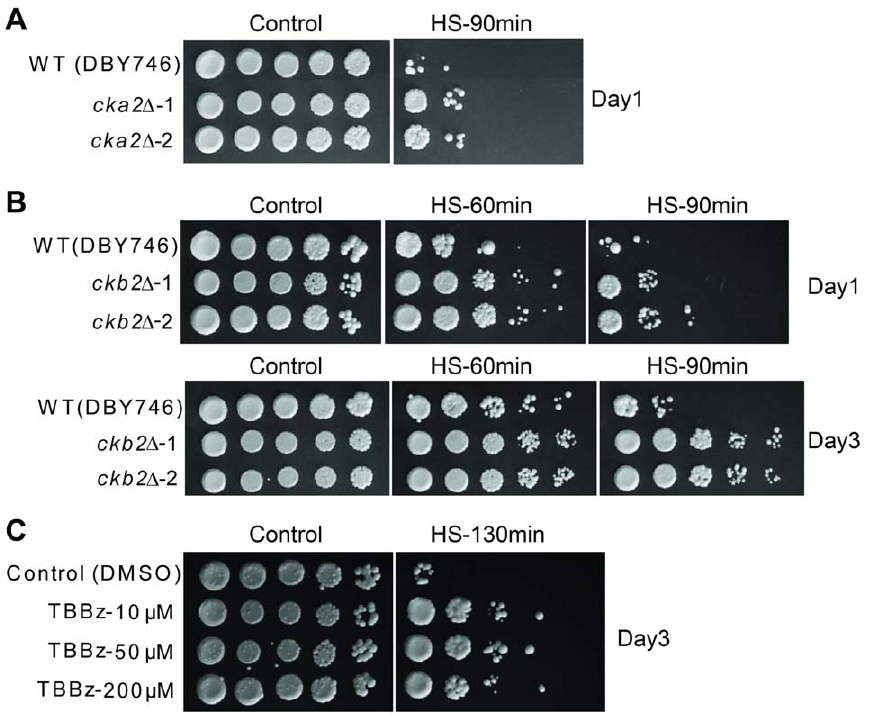
Figure 6. Role of CK2 in the regulation of heat-shock resistance. (A) Heat-shock resistance of two different cka2 D isolates generated in the DBY746 genetic background monitored at day 1. (B) Heat-shock resistance of DBY746 and of two different cultures of the ckb2 D mutant at day 1–3. (C) Heat-shock resistance of DBY746 yeast treated with 10, 50, 200 m M of TBBz at day 2.